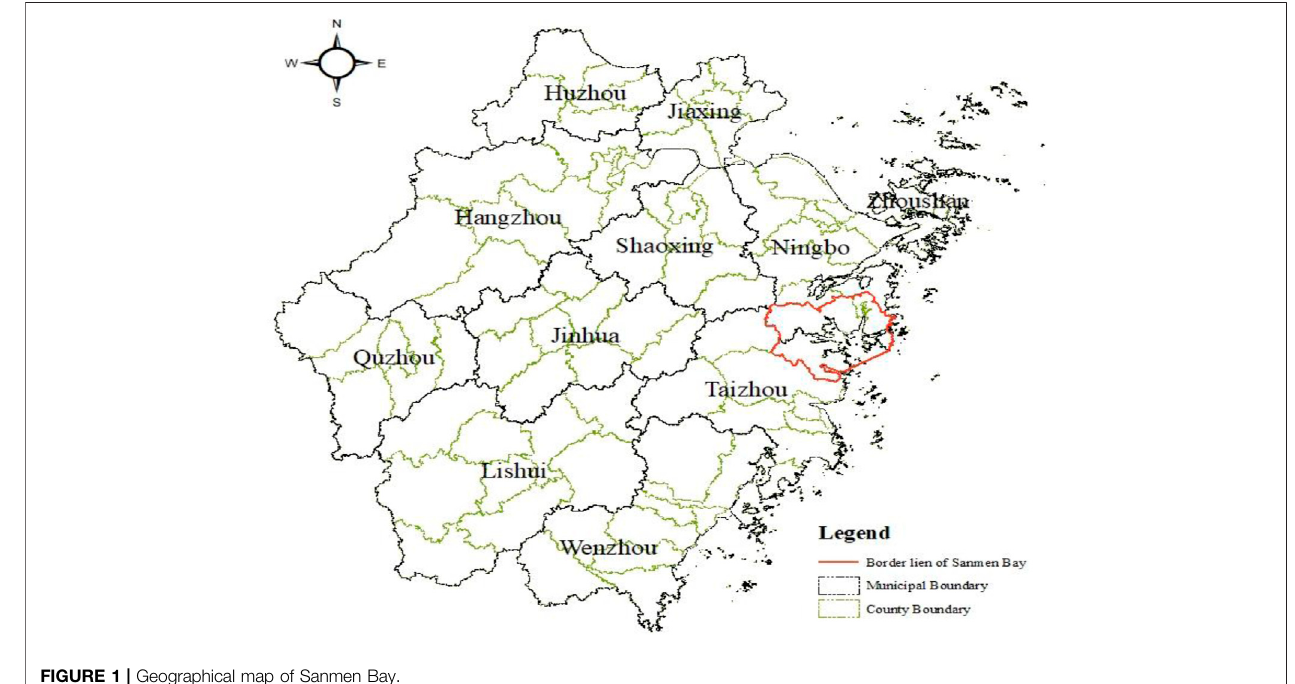
FIGURE 1 | Geographical map of Sanmen Bay.